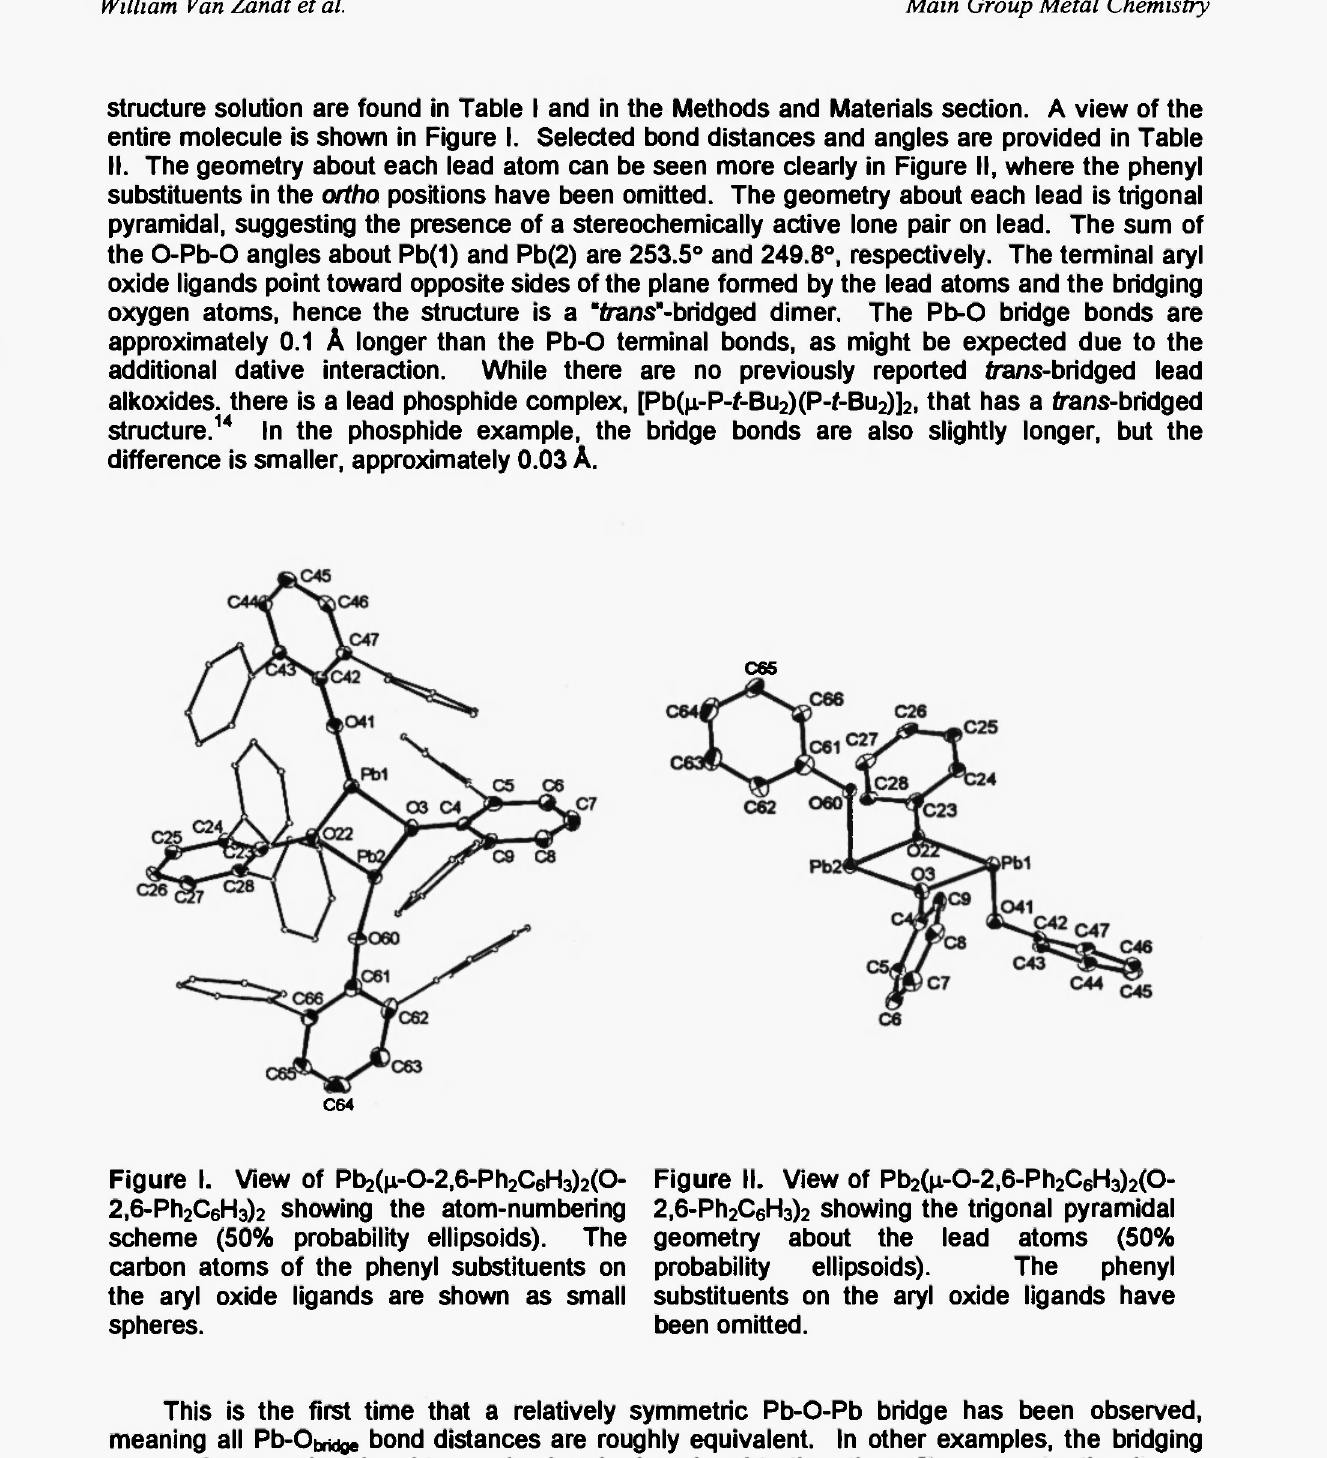
Figure I. View of Pb2^-0-2,6-Ph2C 2,6-Ph2C H3) showing the atom-numbering 6 2 scheme (50% probability ellipsoids). The carbon atoms of the phenyl substituents on the aryl oxide ligands are shown as small spheres.